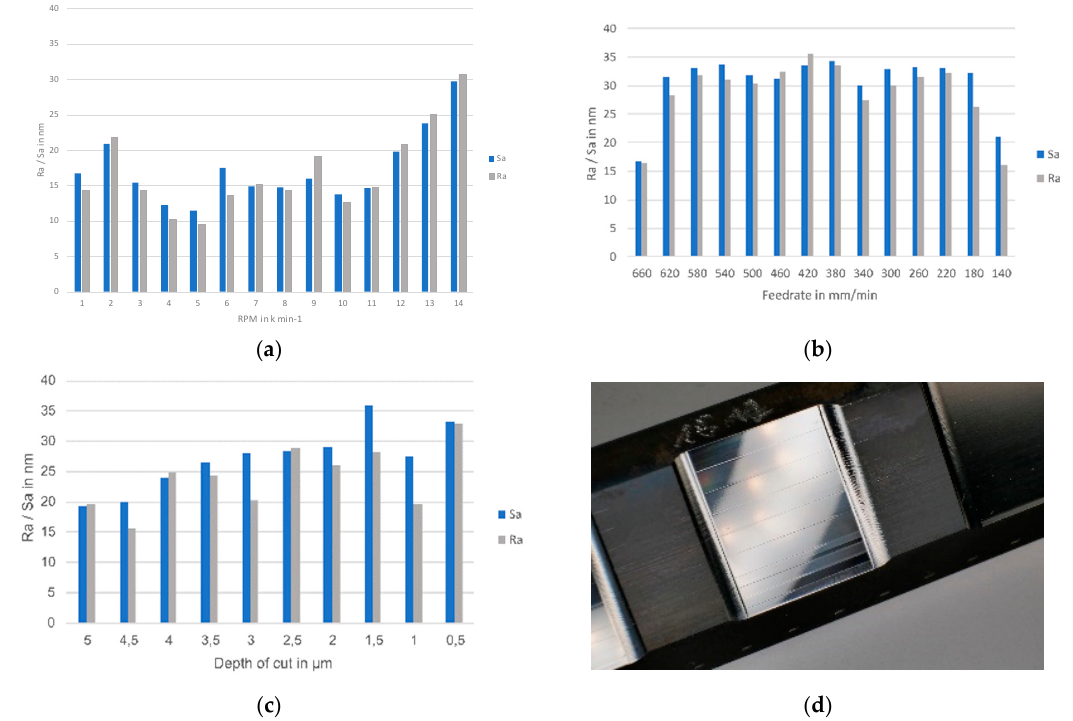
Figure 9. Surface roughness for the spindle speed variation ( a ), feed rate variation ( b ), and depth of cut variation ( c ). Picture of a finished specimen ( d ). The sample area division and gloss are easily recognizable.